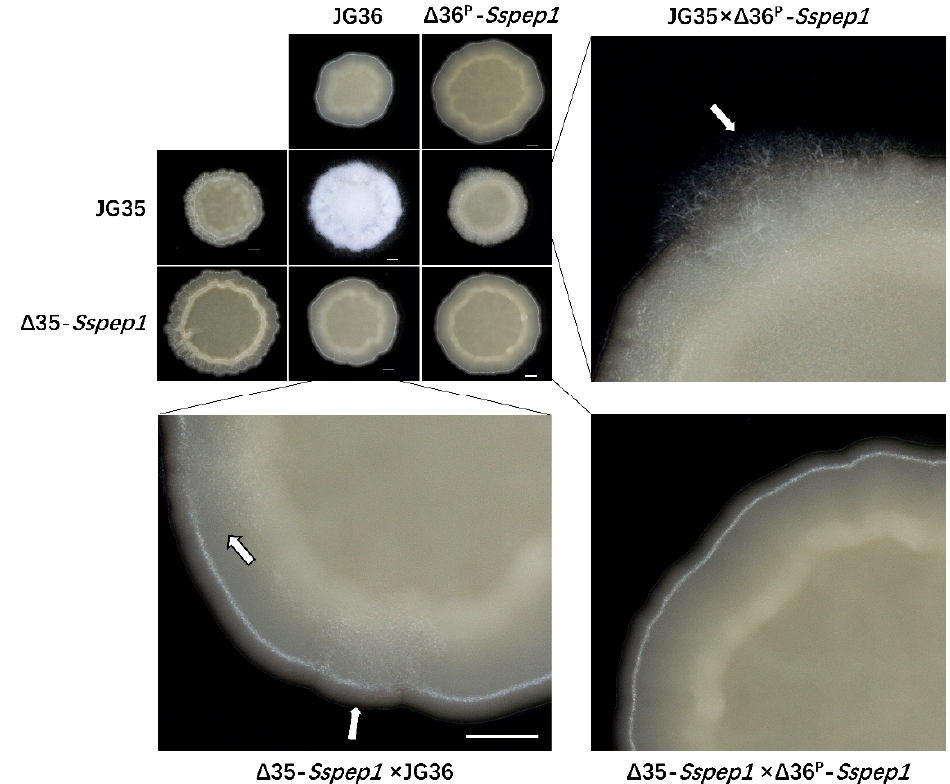
Figure 2. Mating behavior of Sspep1 deletion mutants. Wild-type strains and Sspep1 deletion mutants were co-spotted on YEPS plates and incubated at 28 ◦ C for 72 h. White and fluffy colonies resulting from the formation of dikaryotic hyphae and filamentous growth were indicative of successful mating. Images below and on the right are enlarged colony edges showing the fluffy hyphae (arrow). Colonies were photographed under a stereomicroscope. Scale bars = 1 mm.